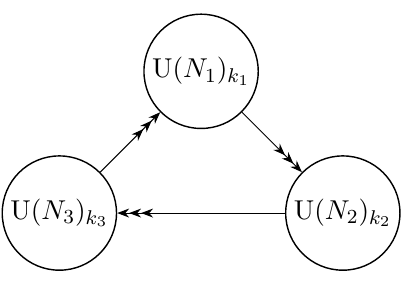
Figure 2 . Quiver diagram for theory with gauge group Π 3